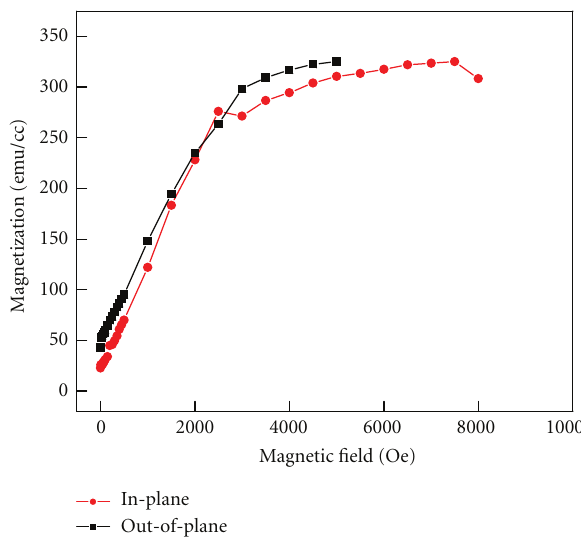
Figure 3: Magnetization versus applied magnetic field of an annealed BTO-MZF nanocomposite film along the in-plane (filled circle) and the out-of-plane (square) directions.